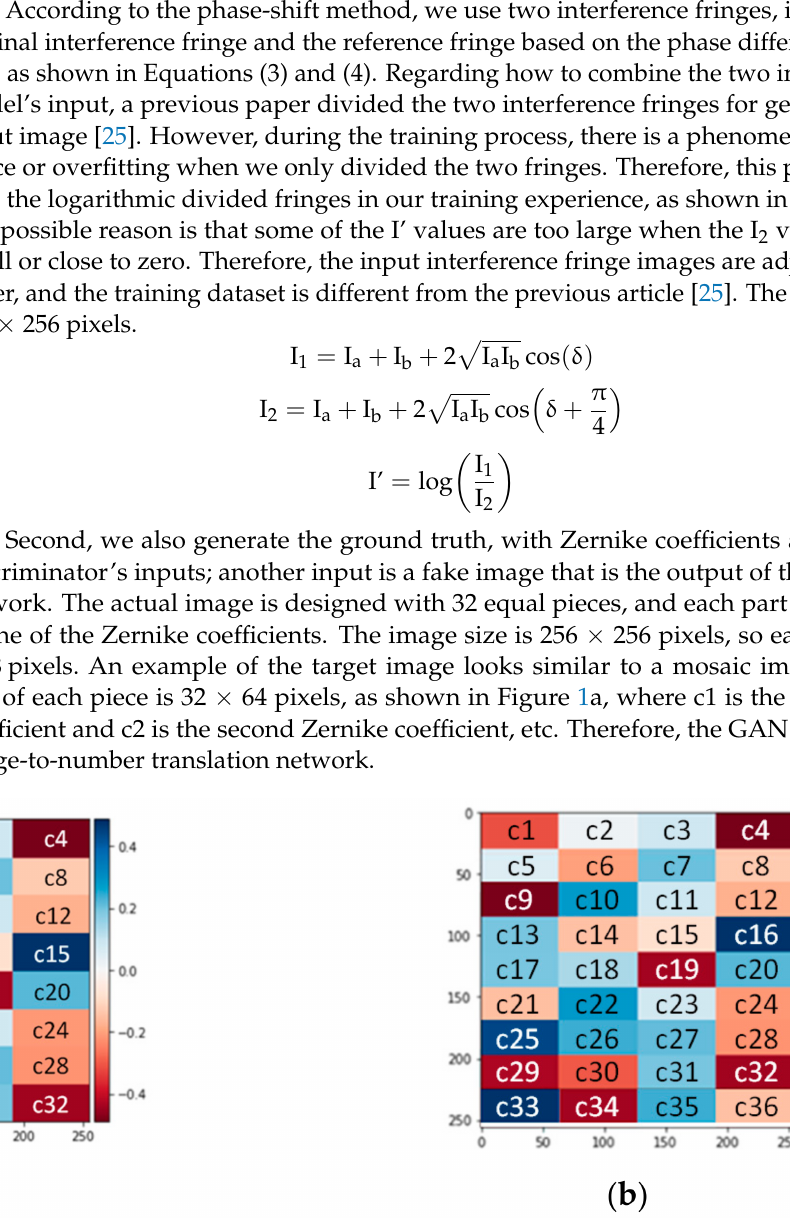
Figure 1. An example of the designed image. ( a ) The 32 Zernike coefficients image. ( b ) The 36 Zernike coefficients image.